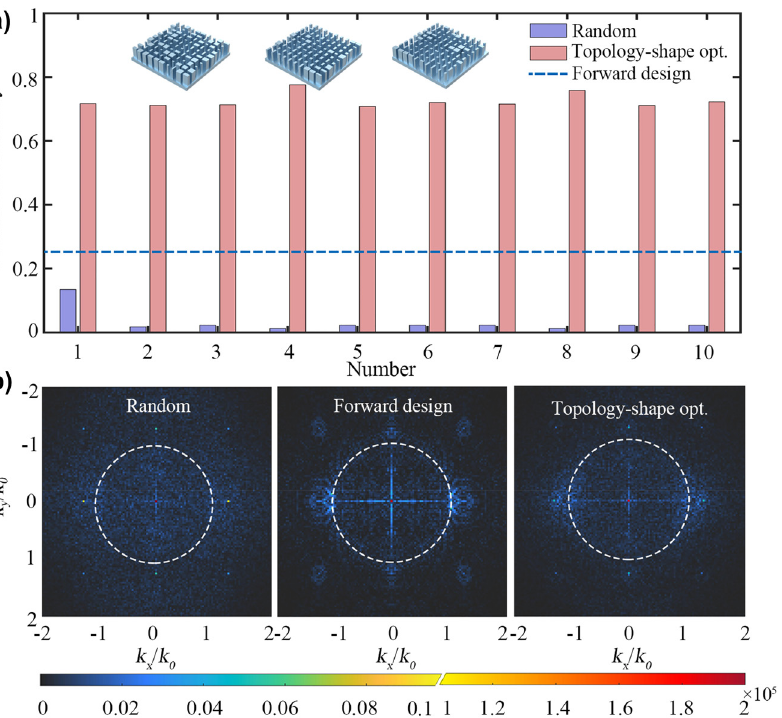
Figure 5: Optimized results for different initial random structures. (a) Diffraction efficiency comparison for initial random metalens, topology-shape optimized metalens, and forward-designed metalens. The insetsshowthestructureof threetypicaloptimizedmetalensat a5 μ m × 5 μ mregion.(b)Fouriertransformoftheelectric fi eldinthenear- fi eld (0.1 λ from the structure) of xoy plane. From left to right are initial random metalens, forward-designed metalens, and topology-shape optimized metalens. The white dashed line corresponds to k 2